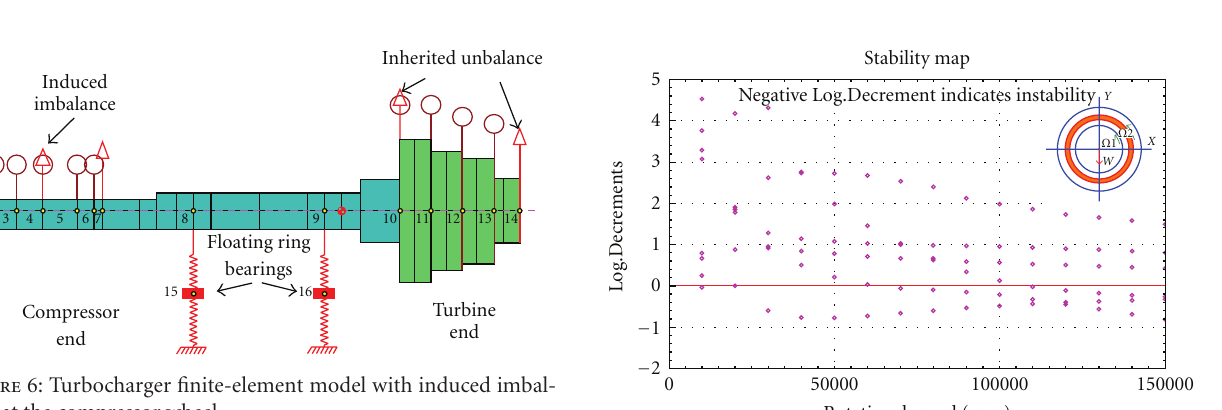
Figure 5: Floating ring bearing data input at compressor end.